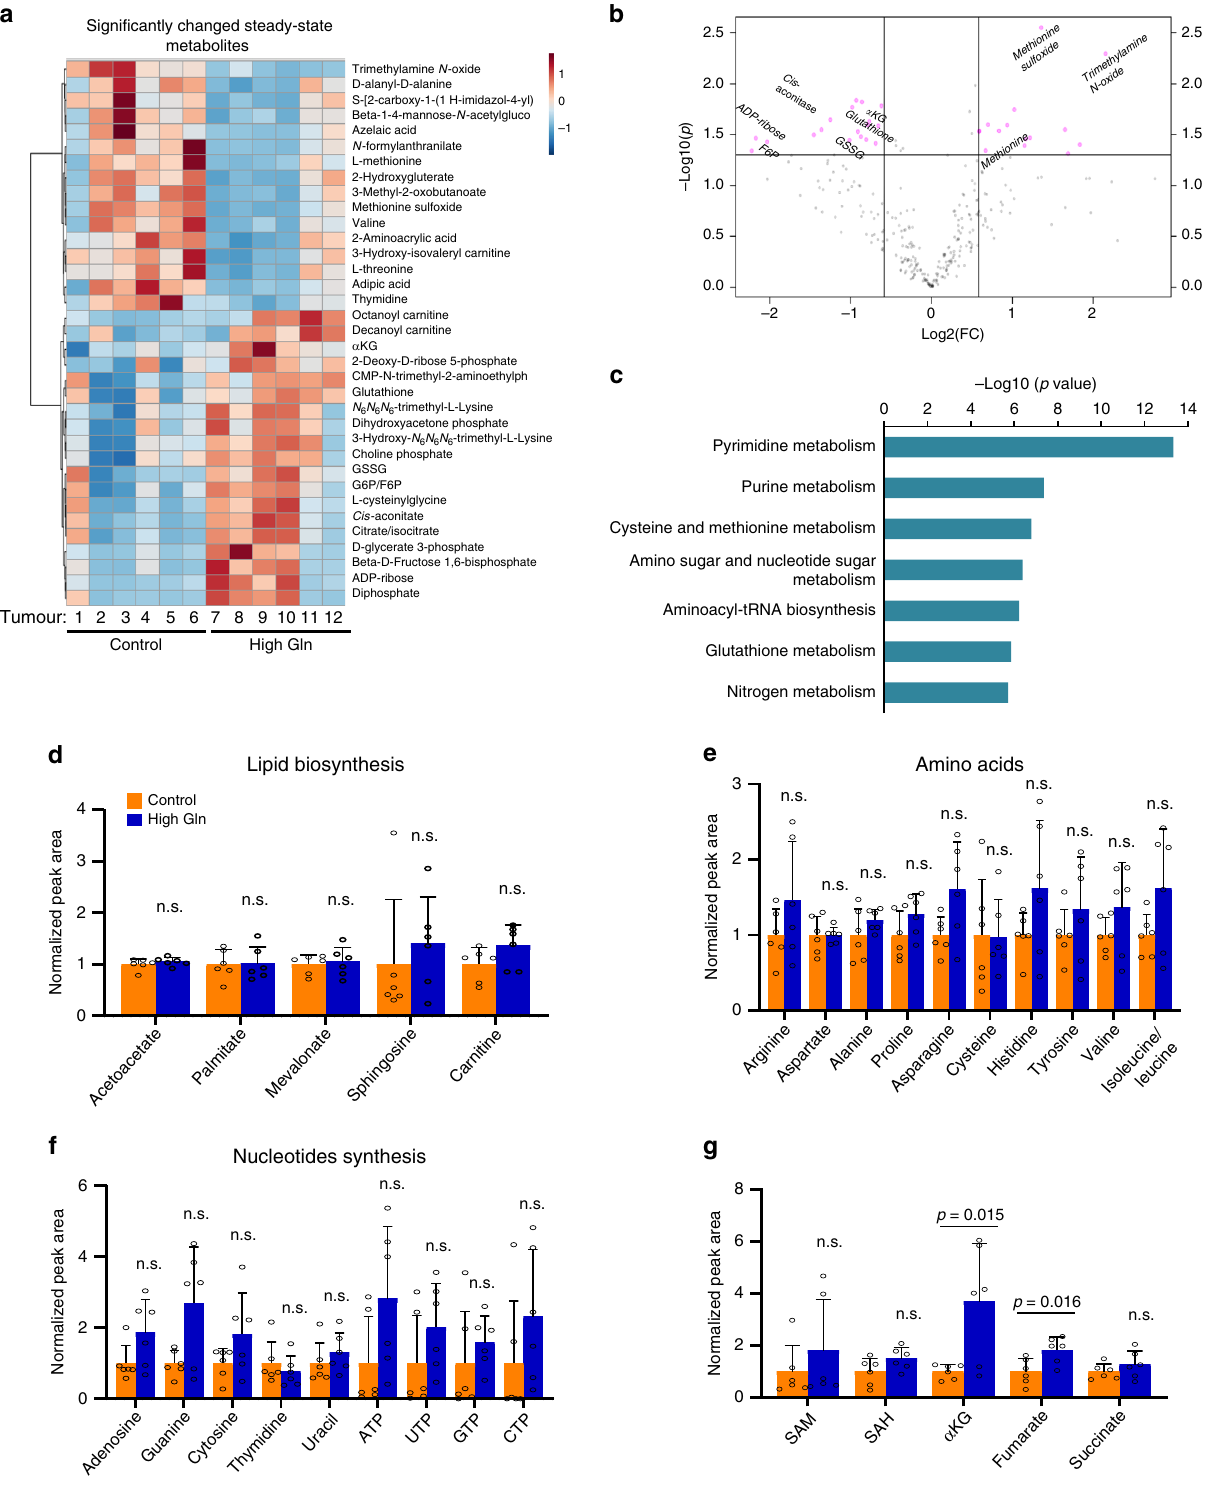
Fig. 5 Dietary glutamine increases α KG in vivo. a Heat map of metabolites measured by LC-MS in PDX_TM00702 tumours ( p < 0.05, n = 6, biological replicates in each group). b Volcano plot of signi fi cantly (represented in pink-coloured dots) changed metabolites. c Pathway analysis on signi fi cantly changed ( p < 0.05 and FDR < 0.05) metabolites in control versus high glutamine PDX_TM00702 tumours. d – f Peak area of the selected metabolites related to lipid biosynthesis in d , amino acids in e and nucleotide synthesis in f normalized to control tumours (Control, n = 6; High Gln, n = 6 biologically independent tumours). g Peak area of the selected epigenetic-related metabolites normalized to control tumours (Control, n = 6; High Gln, n = 6 biologically independent tumours). Data represent means and error bars are s.d. p value calculated by t test (unpaired, two tailed). n.s. not signi fi cant. Source data are provided as a Source data fi